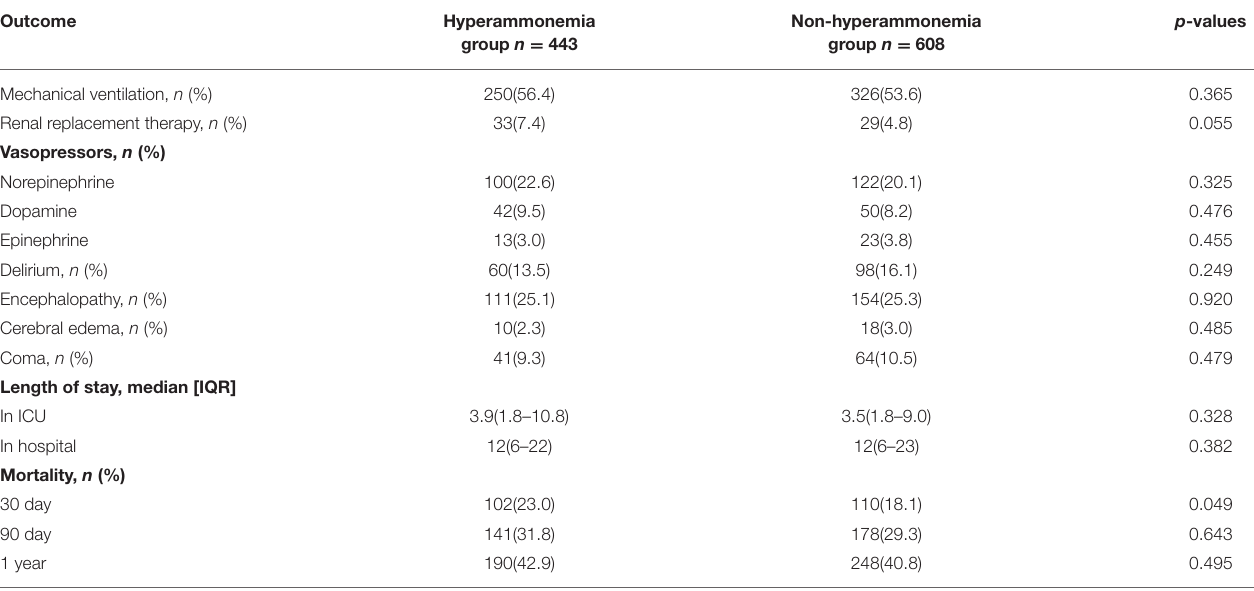
TABLE 2 | Outcomes of the hyperammonemia and non-hyperammonemia